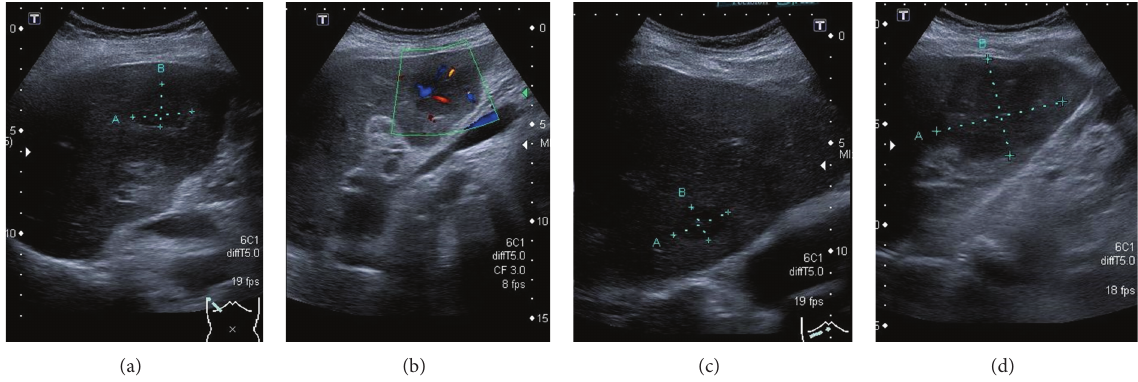
Figure 4: Ultrasonography. Low-echo masses, 3cm, 6 cm, and 3 cm in size, were revealed at segments 5, 6, and 8, respectively ((a)–(d)). Penetrating vessels were evident among the masses (b).